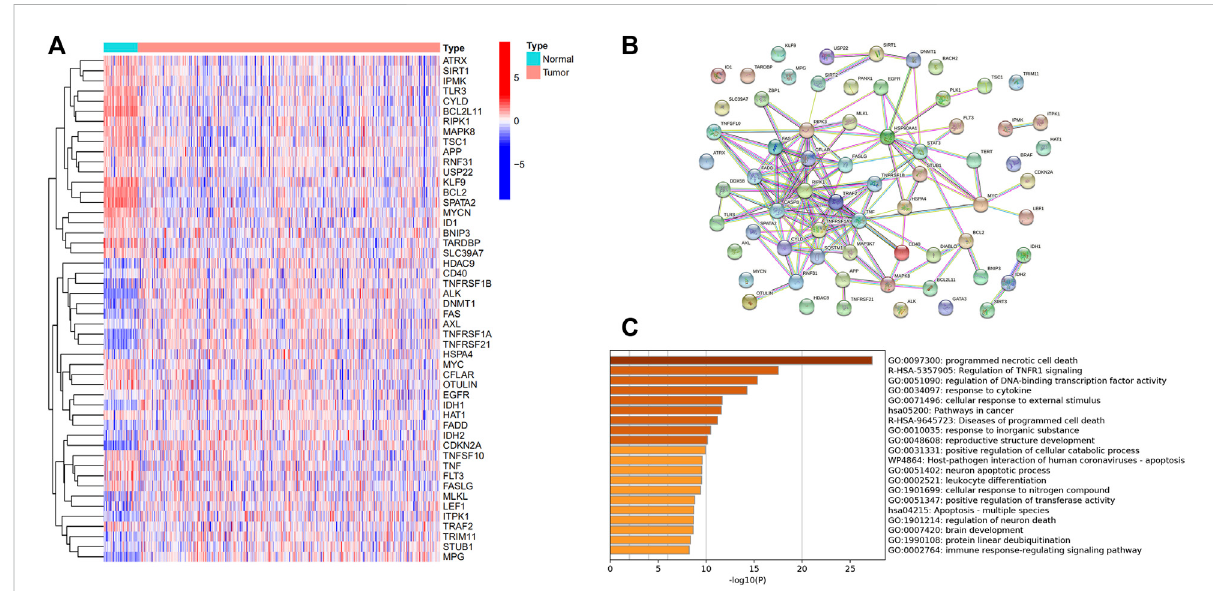
FIGURE 1 Expression ofthenecroptosis-related genesinTHCA( N =498). (A) Theheatmapshowed theexpression levels of50necroptosis-relatedDEGs in normal and tumor samples; (B) PPI network indicated the interactions of the necroptosis-related genes; (C) GO and KEGG enrichment analysis of necroptosis-related